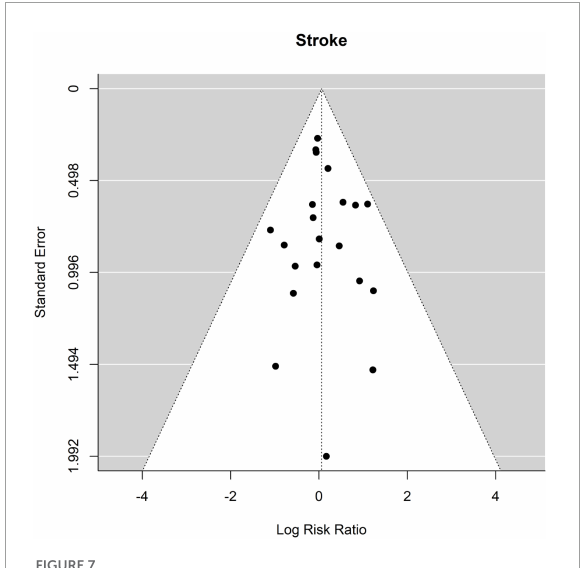
FIGURE7 Relative risk of stroke in patients undergoing aortic interventions with conventional elephant trunk (ET) vs. frozen elephant trunk (FET). Funnel plot.